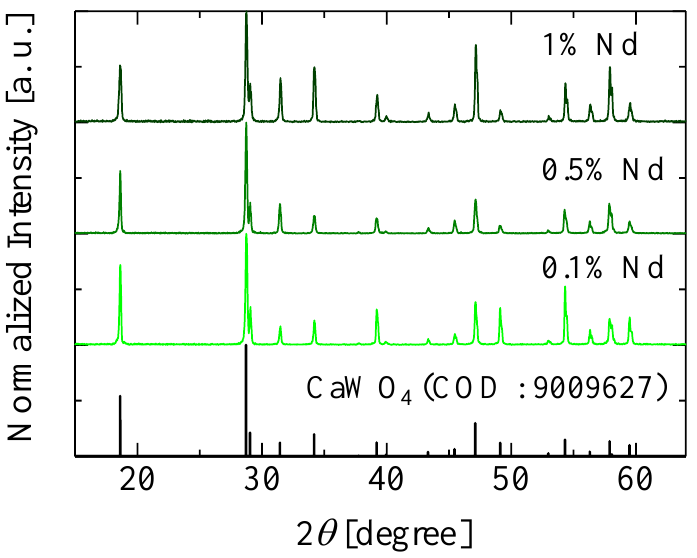
Figure 2. XRD patterns of Nd-doped CaWO 4 with reference.